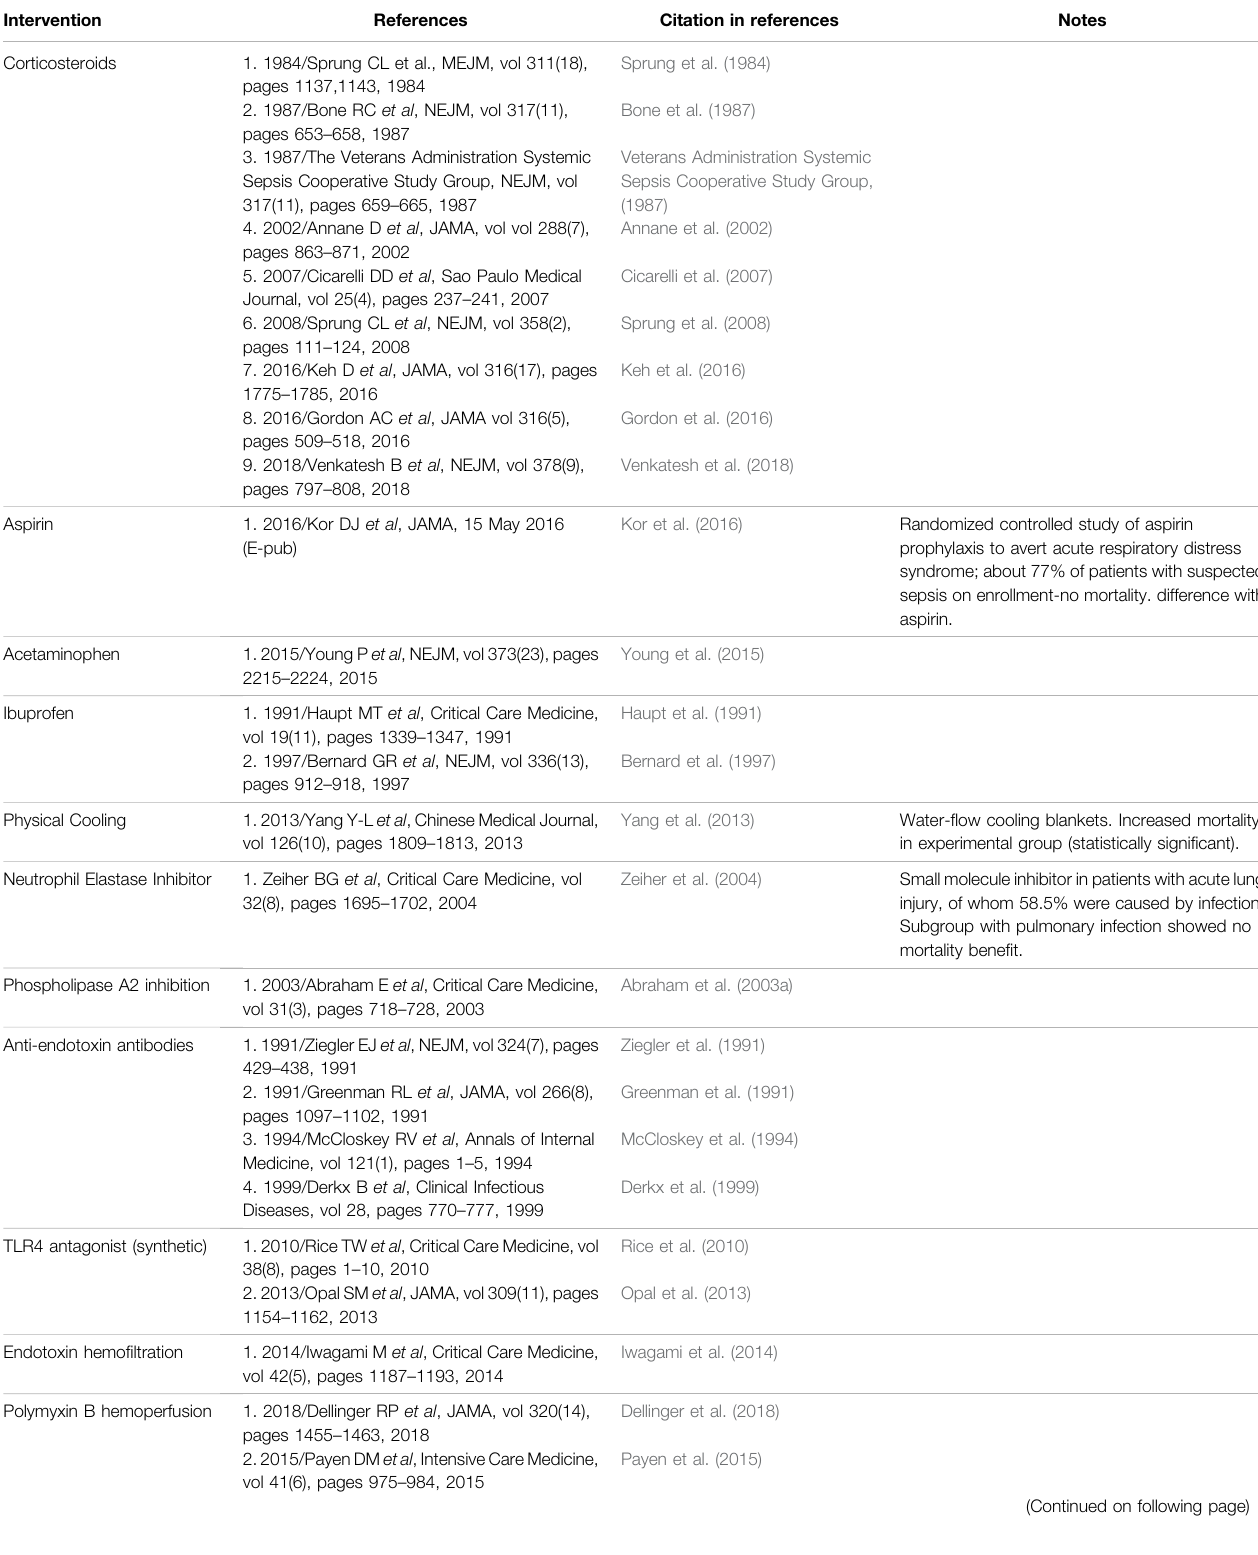
TABLE 1 | Clinical studies evaluating anti-in fl ammation strategies to treat